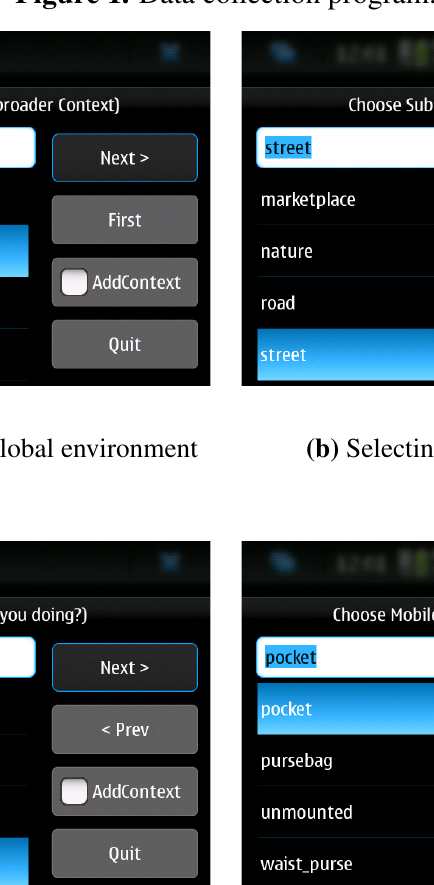
Figure 1. Data collection program.